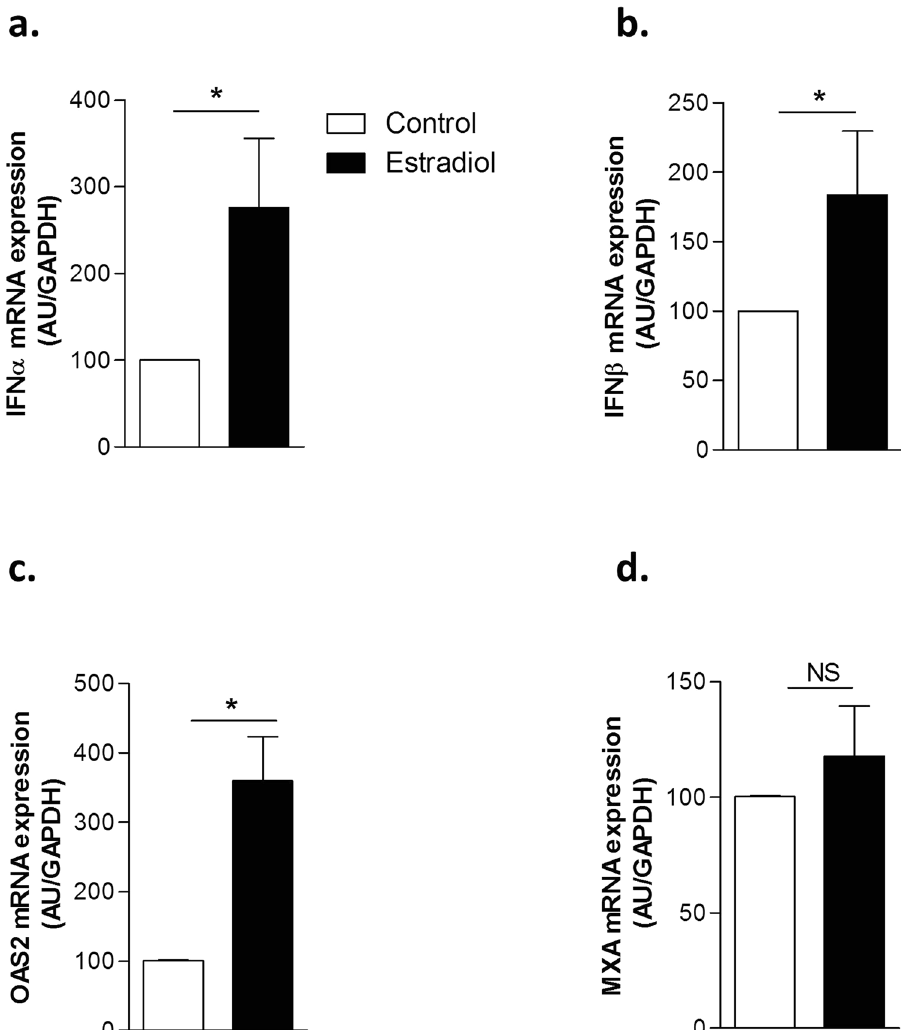
Figure 6. Modulation of interferon α , β , OAS2 and MXA gene expression in human primary cultured TECs by β -estradiol. Effects of 17- β estradiol (10 − 8 M) on IFN α ( a ), IFN β ( b ), OAS2 ( c ) and MXA ( d ) mRNA expression in human primary TECs. Total mRNA were extracted from four different cultured human TECs treated for 24 h. P values were obtained using the Mann-Whitney